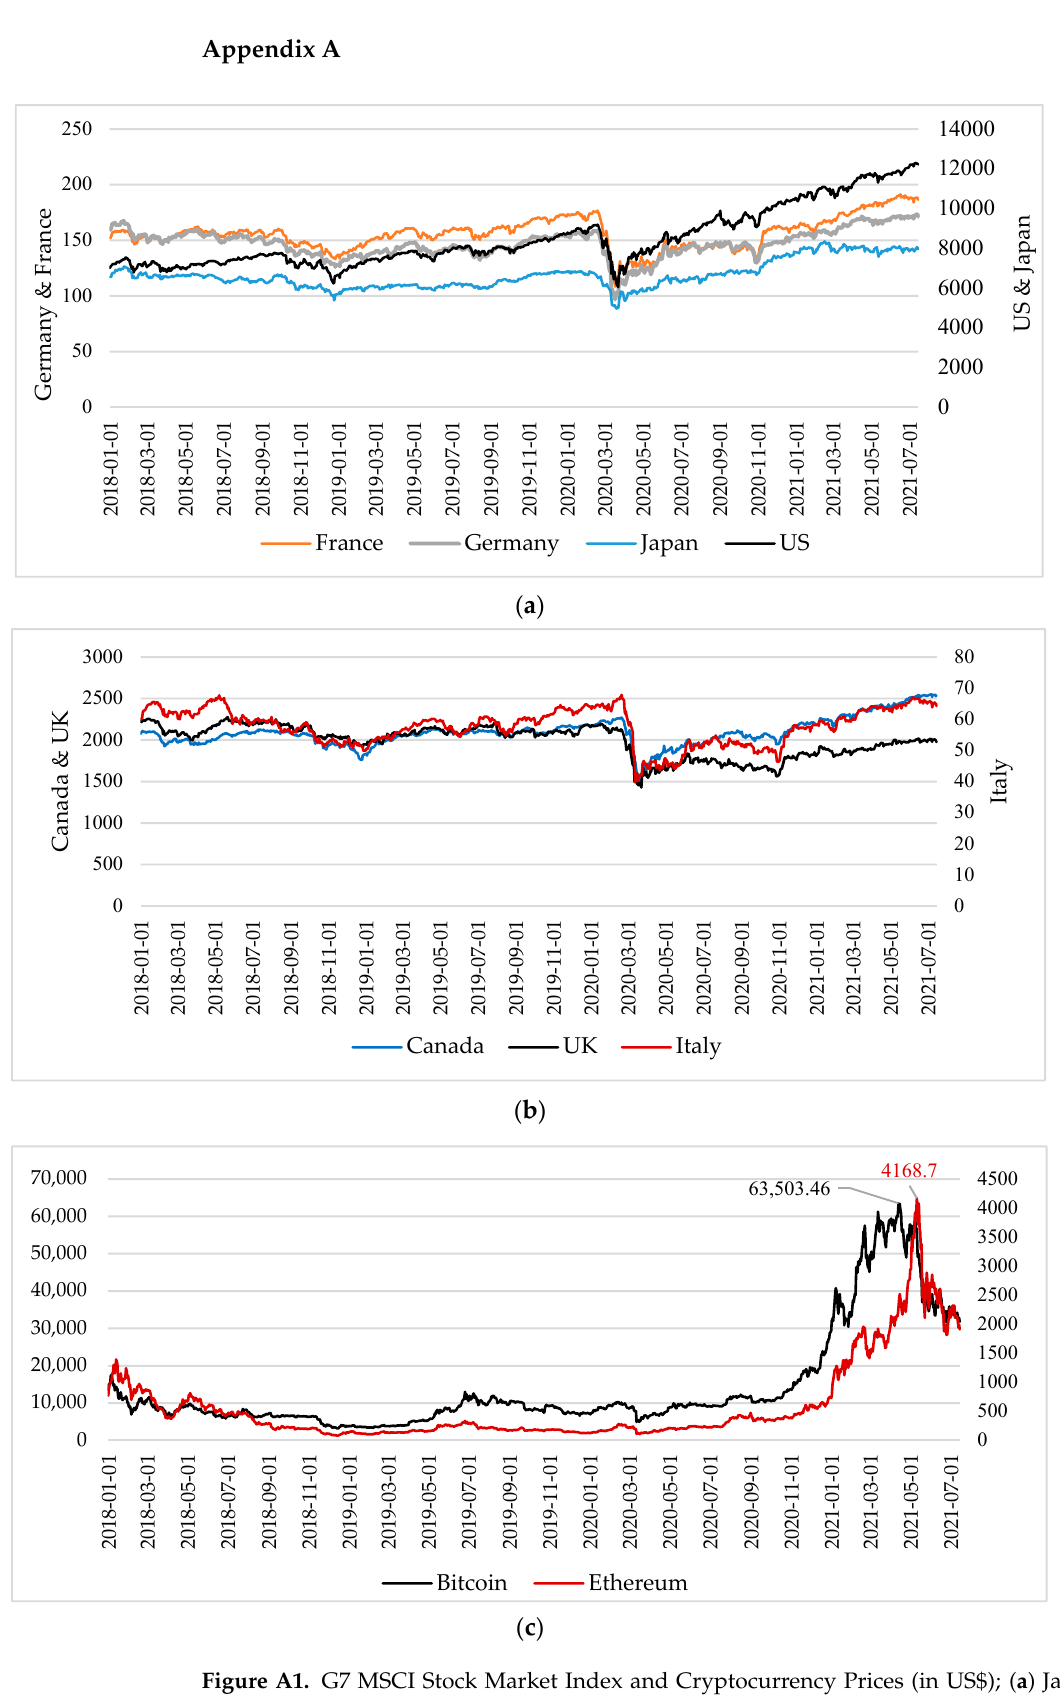
Figure A2. COVID-19, new cases per million population in G7 countries. Source of data: Oxford University’s Our World in Data (OWID) database. Appendix B Table A1. SUR Estimation on Short Run Stock-Cryptocurrency Comovements. Market